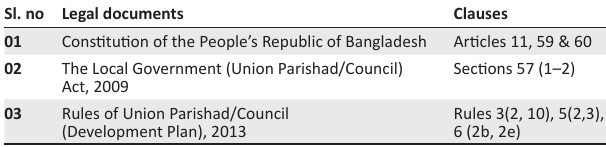
TABLE 1-A2: Legal basis of local government union council budgeting. Sl. no Legal documents